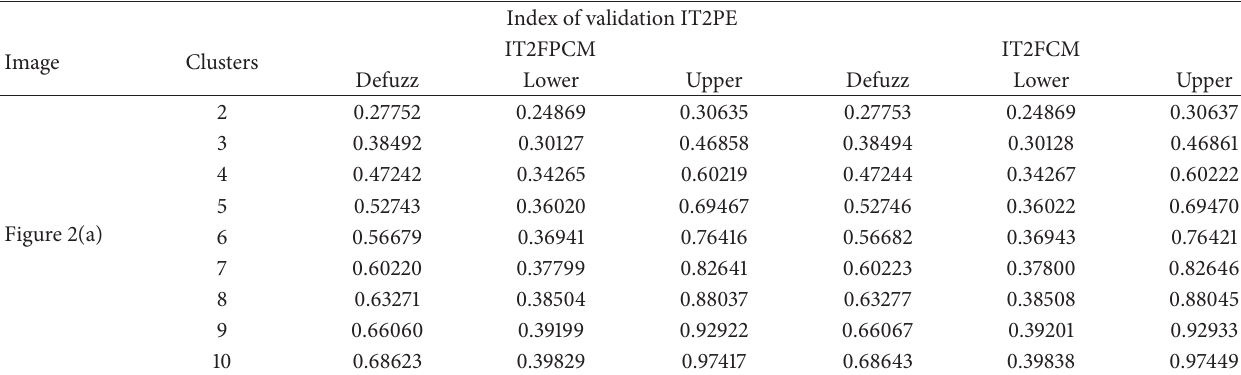
Table 26: Results of the IT2PE validation index to the clustering of image shown in Figure 2(a) using IT2FPCM and IT2FCM algorithms with 𝑚 = [1.5, 2.5] and 𝜂 = [1.5, 2.5] as parameters.